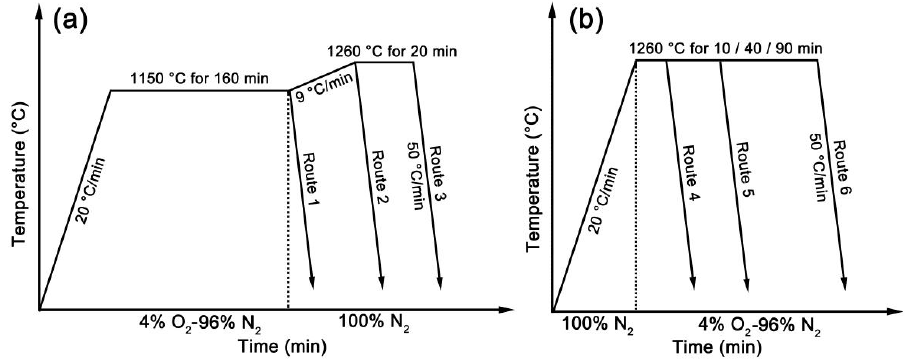
Figure 1. Oxidation experiment routes: ( a ) Routes 1–3; ( b ) Routes 4–6.